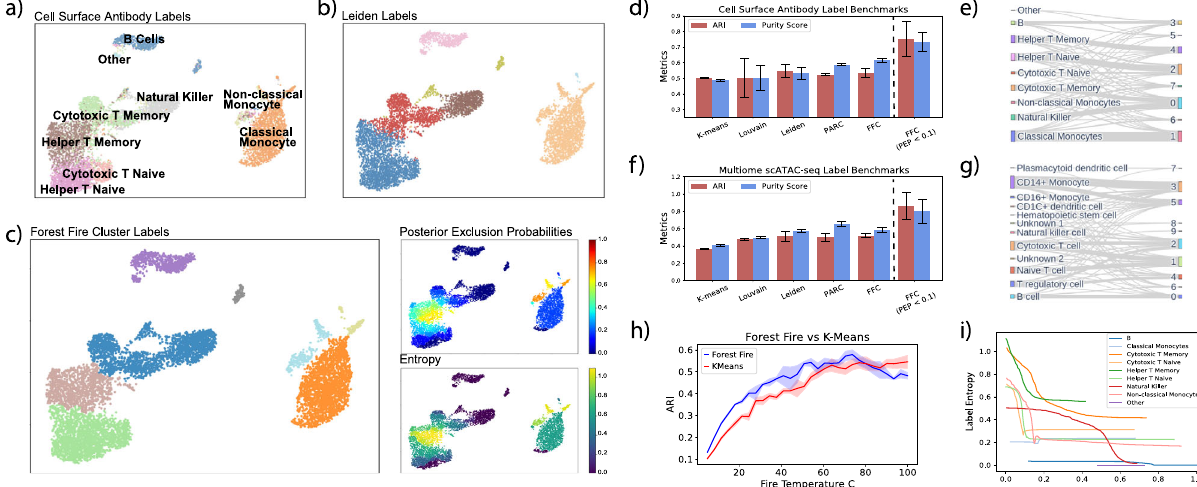
Fig. 5 Benchmarking Forest Fire Clustering on PBMC data. a Ground-truth cell-surface antibody labels. b Leiden cluster labels. c Forest Fire clusters with point-wise posterior exclusion probabilities and label entropies from internal validation. d Clustering quality benchmarks using labels generated by cell- surface-protein levels while clustering the gene expression ( n = 20 different seeds). e Sankey diagram of surface-protein labels and Forest Fire clusters on gene expression. f Clustering quality benchmarks using labels generated by marker genes while clustering the ATAC peaks ( n = 20 different seeds). Data are presented as mean values + / − 2SD. g Sankey diagram of marker-gene labels and Forest Fire clusters on ATAC peaks. h When Forest Fire Clustering was used to discover the number of clusters K , the cluster quality with Forest Fire Clustering is often better than the cluster quality with K -means (using the same number of clusters K and n = 20 different seeds). Since Forest Fire Clustering outperforms K -means over a wide range of fi re temperatures, the results also indicate that Forest Fire Clustering can discover high-quality clusters at different cluster resolutions. i Point-wise label entropy versus diffusion pseudotime. Within most surface-protein-labeled cell types, the label entropy decreases as diffusion pseudotime